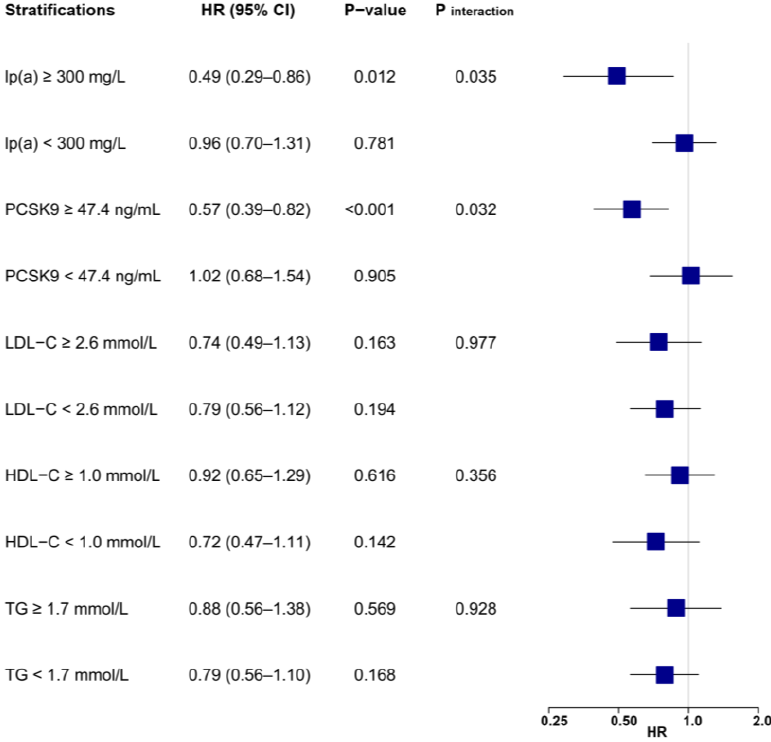
Figure 4. Associations between LL-37 and the risk of MACE according to lipid profile values. Multivariable Cox regression was adjusted for variables with p < 0.1 in univariable analysis (see Supplementary Table S1), including age, gender, body mass index, hypertension, previous myocardial infarction, heart rate, ejection fraction, leucocytes, hemoglobin, creatinine, glucose, hemoglobin A1c, high-sensitivity C-reactive protein, cardiac troponin I, N-terminal prohormone of brain natriuretic peptide, LDL-C, culprit lesion, multivessel disease, successful revascularization, P2Y12 inhibitor, and statin. HDL-C = high-density lipoprotein cholesterol; LDL-C = low-density lipoprotein cholesterol; lp(a) = lipoprotein(a); MACE = major adverse cardiovascular event; PCSK9 = proprotein convertase subtilisin/kexin type 9; TG = triglyceride.